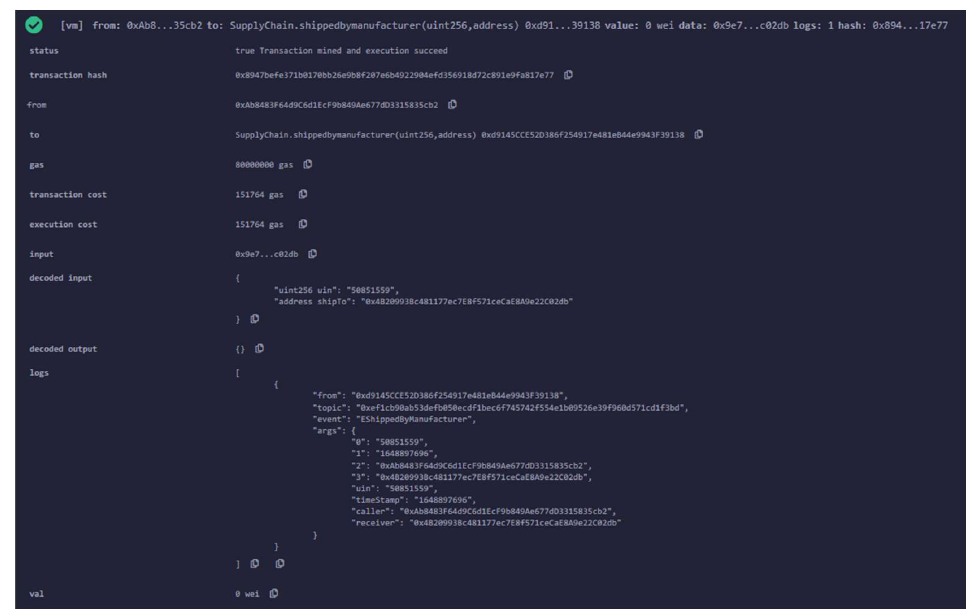
Fig. 8. Product is successfully added to the blockchain.